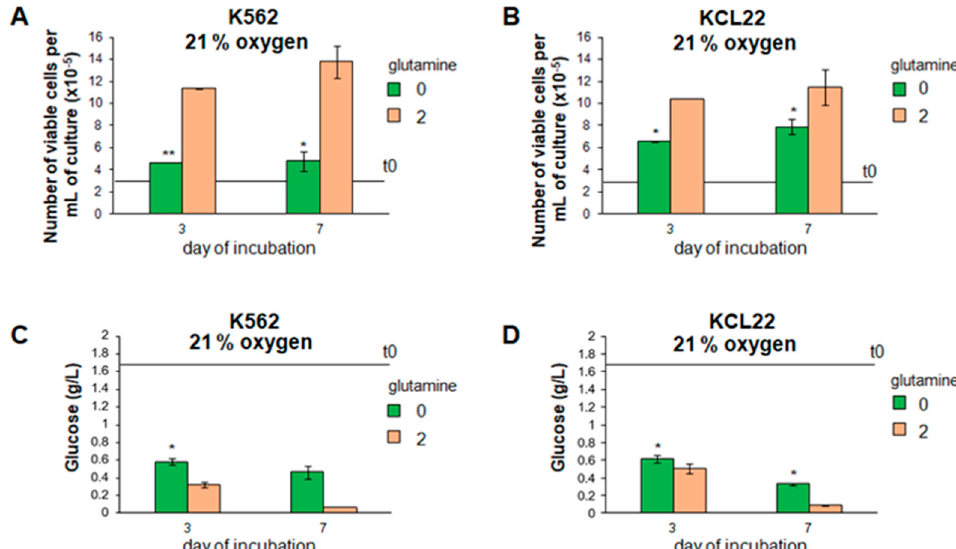
Figure 1. Effects of the lack of glutamine on cell growth and glucose consumption in “normoxia”. K562 ( A , C ) or KCL22 ( B , D ) cells were seeded at 3 × 10 5 cells/mL and incubated in standard atmosphere (21% O 2 ) in the absence or the presence of glutamine from time 0 (t0) of incubation. Trypan blue-negative cells were counted ( A , B ) and glucose concentration in culture medium was measured ( C , D ) at the indicated times. Horizontal bars indicate t0 values. Values are mean ± S.D. of data obtained from 3 independent experiments; 0 vs. 2 mM glutamine: * p < 0.05, ** p < 0.01.